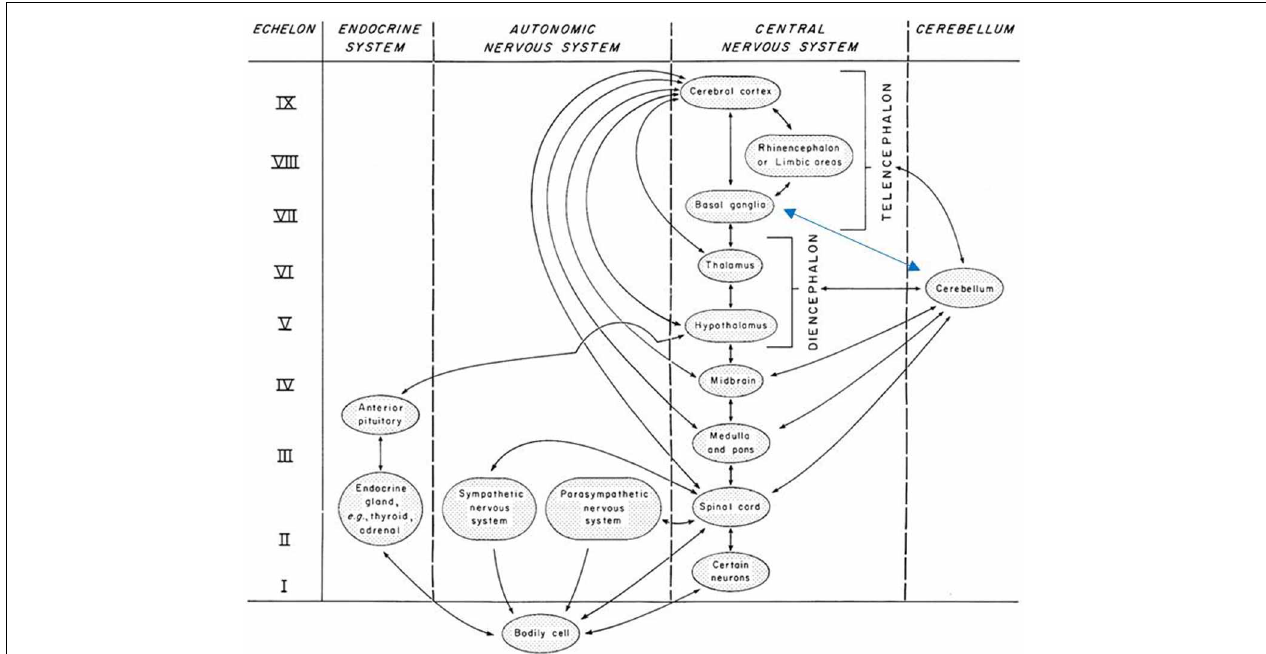
FIGURE 1 | Nine echelons of decider subsystems in higher mammals. Note: Reproduced from original Figures 8–6 Echelons of the decider subsystem of higher mammals , p. 423, in Miller (1995), with written